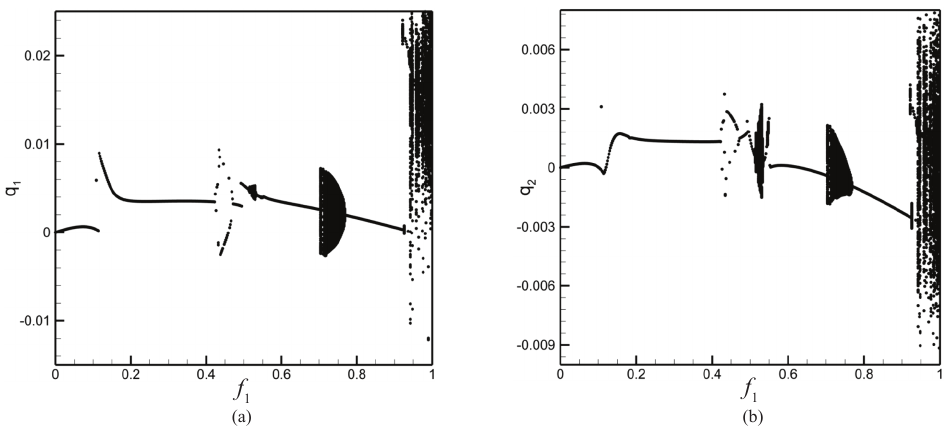
Fig. 18. Bifurcation diagrams of Poincaré points for increasing forcing amplitude on the system with γ T = 0 . 6 .